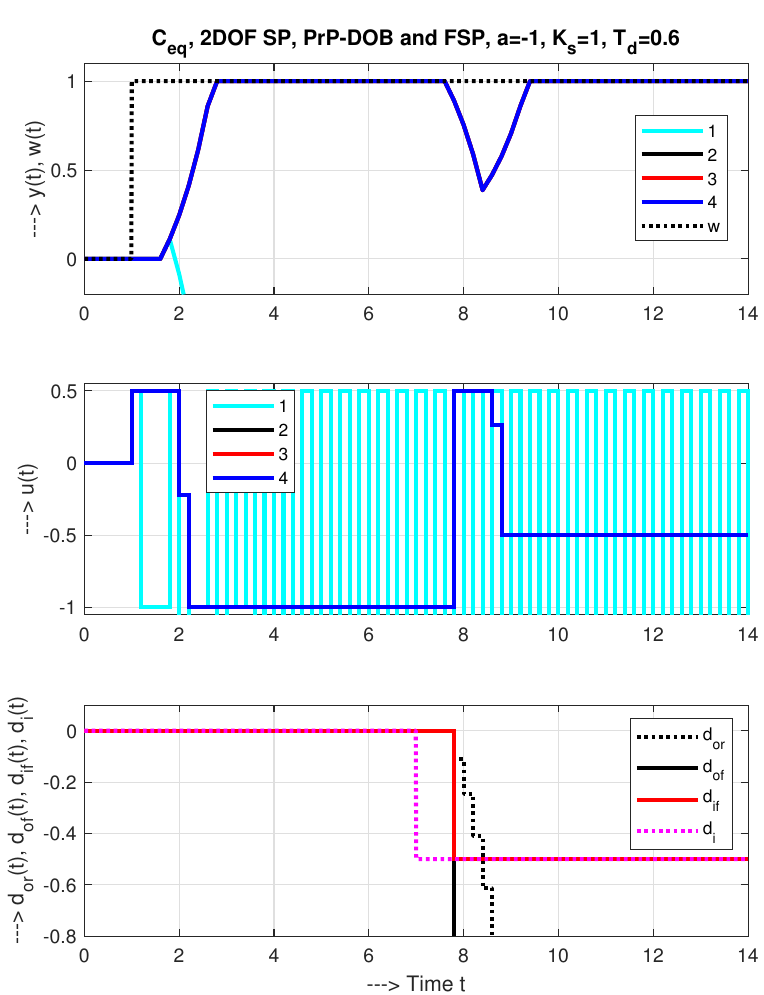
Figure 11. Transients corresponding to constrained u ∈ [ − 1.1,0.5 ] control with (1) nominal dead-beat tuning of the equivalent controller C eq (Equation (56)), (2) 2-DoF SP (according to Figure 8 middle) with reconstruction and compensation of output disturbances (2-DoF SP), (3) PrP-DOB control From Example 1, (4) FSP (according to Figure 8 down) with dead-beat tuning specified in Example